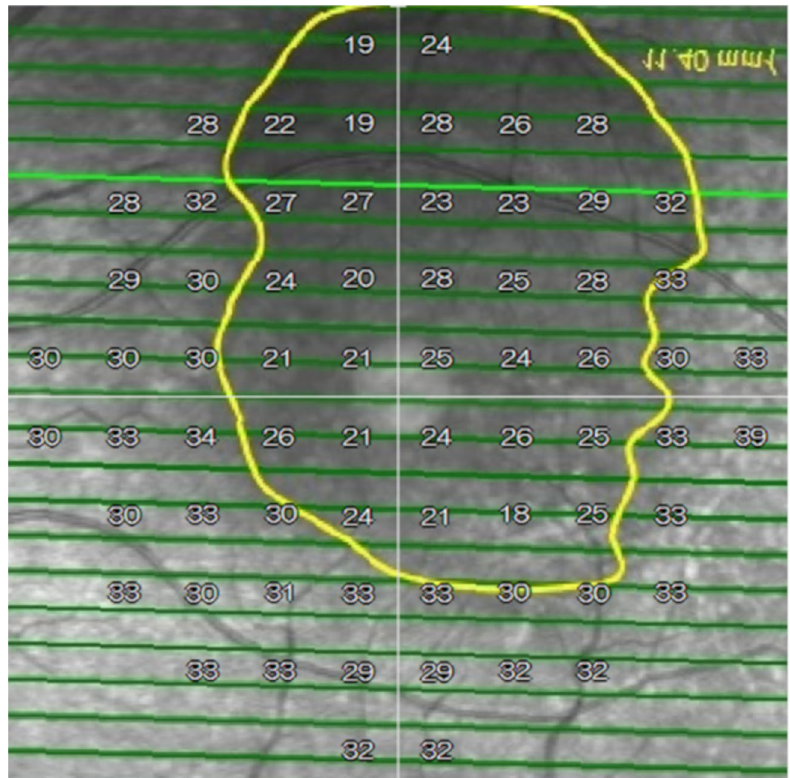
Figure 3. The optical coherence tomography image of the serous retinal detachment region and the perimetry results were superimposed using the built-in software in the AP-7000 automatic perimeter (AP-7000 Software Ver.3.0.6.0, KOWA Company Ltd., Tokyo, Japan). The software automatically inverts the retinal image to correspond to the visual field results. Hence, the image of the retina will remain inverted in the overlapped image, indicating that the images were correctly